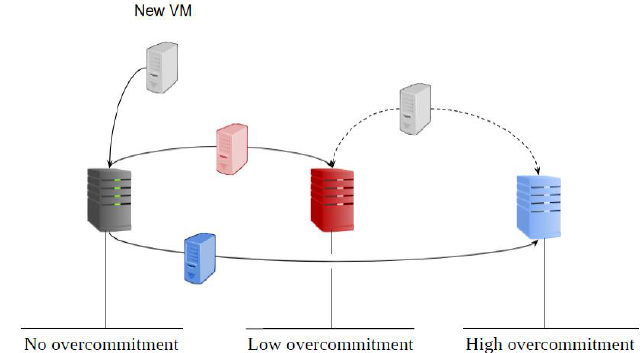
Fig. 3. Overview of the dynamic relocation